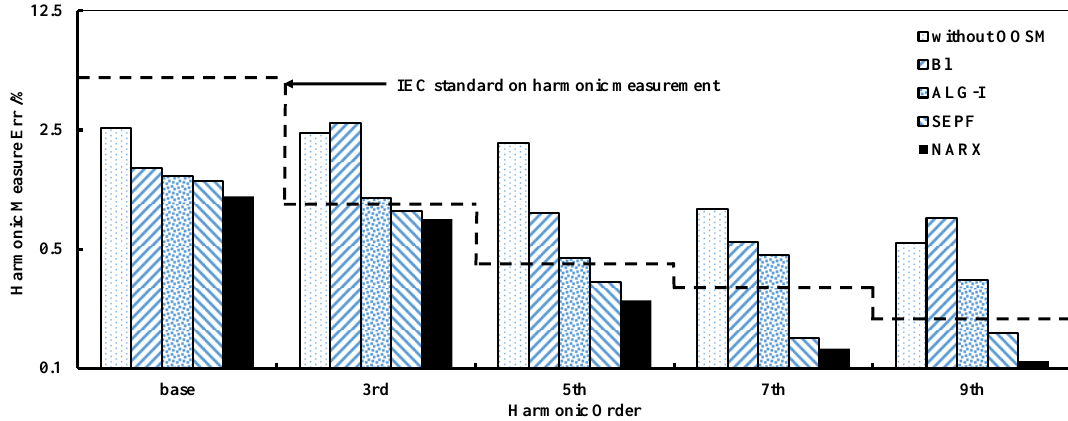
Figure 6. MSE of various harmonic measurements with 4 OOSM algorithms. The dotted line is the upper bound of the harmonic measurement error in the IEC standard 61000-4-7.